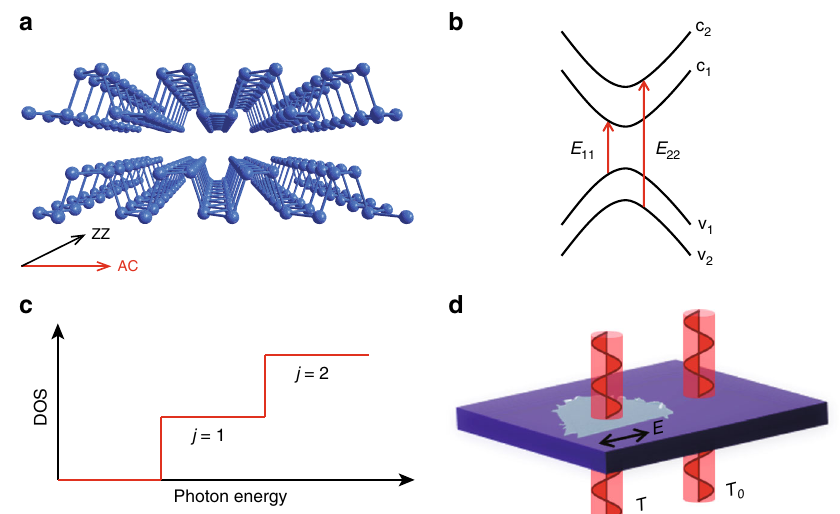
Fig. 1 Crystal structure and IR characterization of few-layer BP. a Puckered structure of 2 L BP, with two characteristic crystal orientations: AC and ZZ. b Schematic illustration of optical transitions between quantized subbands, with the symbols E 11 and E 22 denoting transitions v 1 → c 1 and v 2 → c 2 , respectively. c Illustration of joint DOS in 2D systems, showing step-like features. d FTIR measurement con fi guration with T and T 0 denoting the light transmittance of the substrate with and without BP samples, respectively. The arrow indicates the polarization of the incident IR beam, along the AC direction of the BP sample.